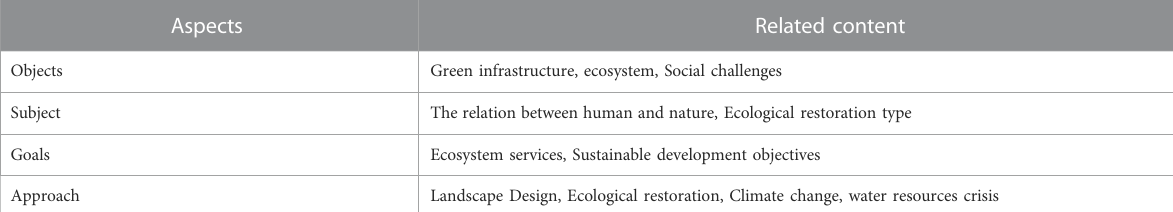
TABLE 3 The main research contents of